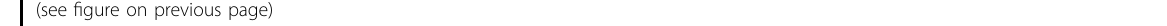
Fig. 4 Conformation transitions of Omicron S – FD01 in all states. The representative bispeci fi c antibody GW01-16L9 (FD01) IgG in complex with the Omicron S trimer. One 16L9 binds to the “ up ” RBD-1 in the apo S trimer (State 0) to form the State 1 complex. Then, the 22-aa GS linker between 16L9 and GW01 guides GW01 to bind to RBD-1 and push it more open to accommodate GW01, which unlocks the “ down ” RBD-2 and induces it to the “ up ” state (State 2). Thus, another 16L9 could easily catch the “ up ” state RBD-2. The same triggering process then occurs on RBD-2 (State 3 and State 4) and RBD-3 (State 5), allowing the binding of the second and third FD01 to RBD-2 and RBD-3, respectively. Thus, 16L9 scFv and GW01 scFv synergistically induced the RBD-down conformation into 3 RBD-up conformation. Finally, three pairs of Fc regions from FD01s cross-link two trimers and form a trimer dimer (State 6). Black dotted circles show the states of three RBDs in a spike trimer: red triangles represent "up" state, black triangles represent "down" state and the orange one represents "half-up" state. The direction and distance of movement of RBDs from one state to next state is